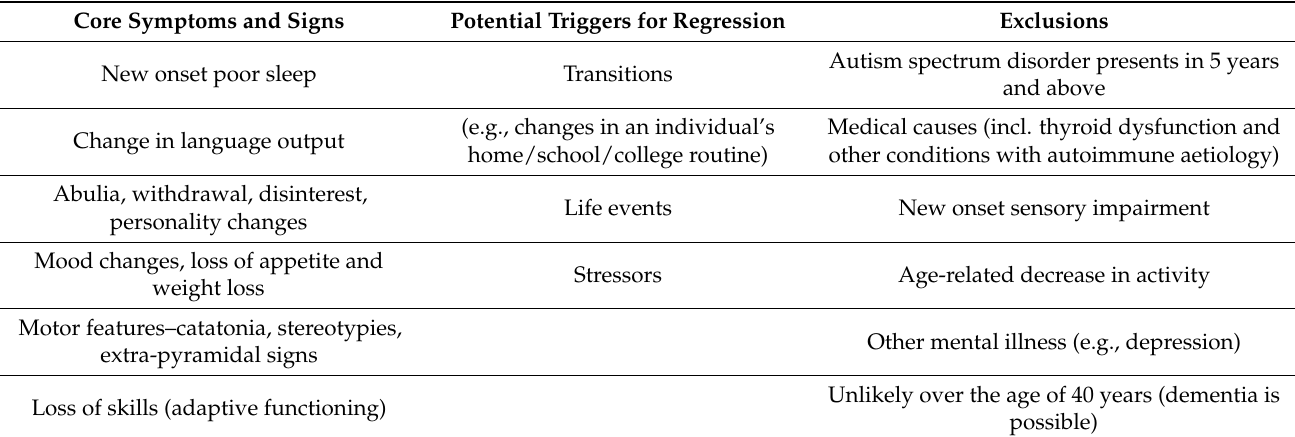
Table 4. Proposed clinical features of